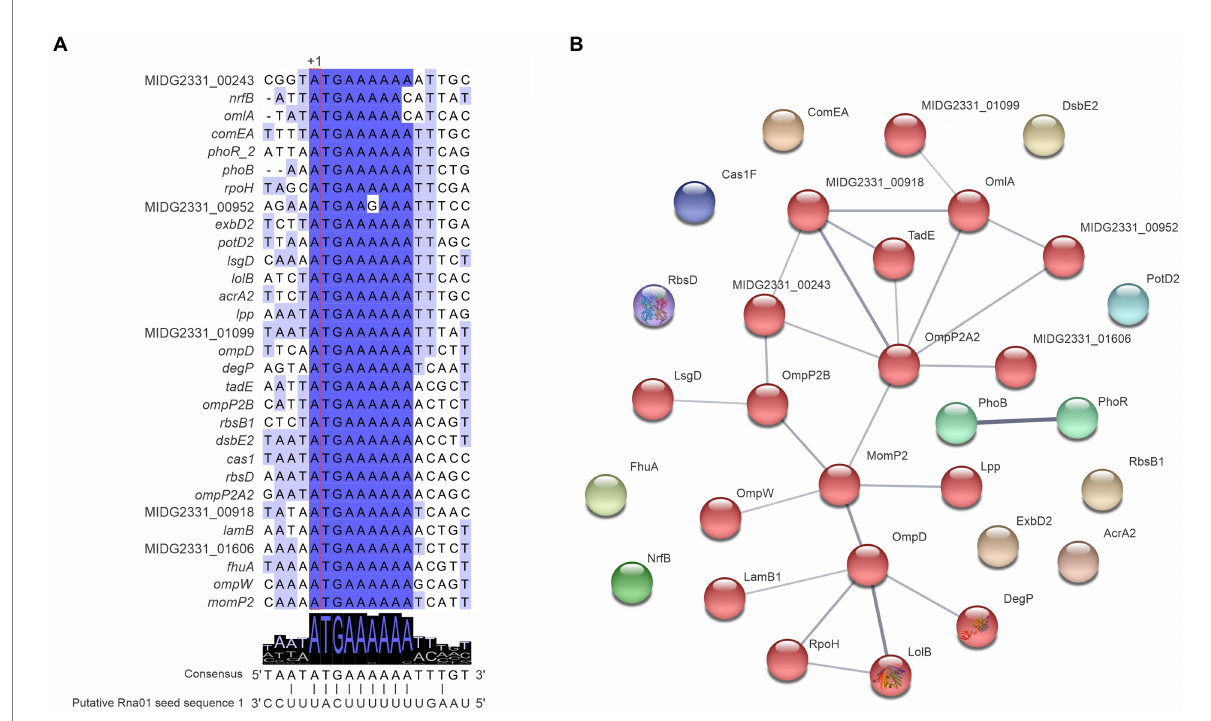
FIGURE 4 Actinobacillus pleuropneumoniae mRNA Targets predicted to be bound by Rna01. (A) Targets of Rna01 manually predicted in the MIDG2331 genome and their interaction with the seed region 1 of Rna01. Predicted translational start sites of Rna01 targets is represented by “+1.” (B) Interaction of manually predicted targets of Rna01. Grey lines represent protein–protein associations, and their thickness indicates the strength of data support. Associations are meant to be specific and meaningful, for example, proteins that jointly contribute to a shared function. Genes were analyzed with a moderate confidence 0.400 and Markov clustering method (MCL) with inflation parameter 1.1. Associated proteins share colors in the